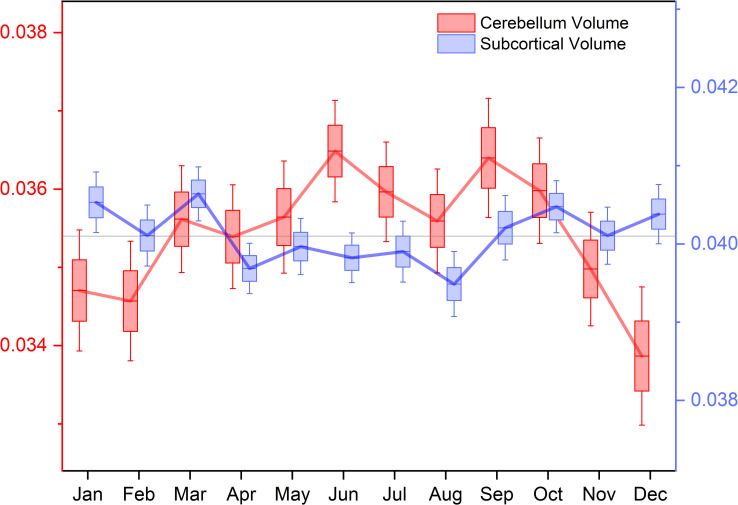
Cerebellum cortex and subcortical volumes compared.Plots aligned to annual mean for each ROI. Box plot indicates standard error, and extension lines indicate 95% confidence interval. Thick line indicates mean volume.